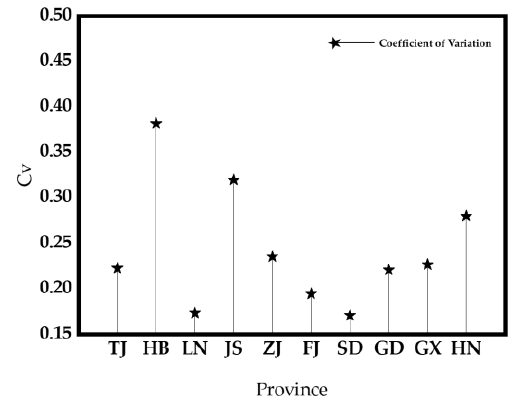
Figure 2. C V of regions.